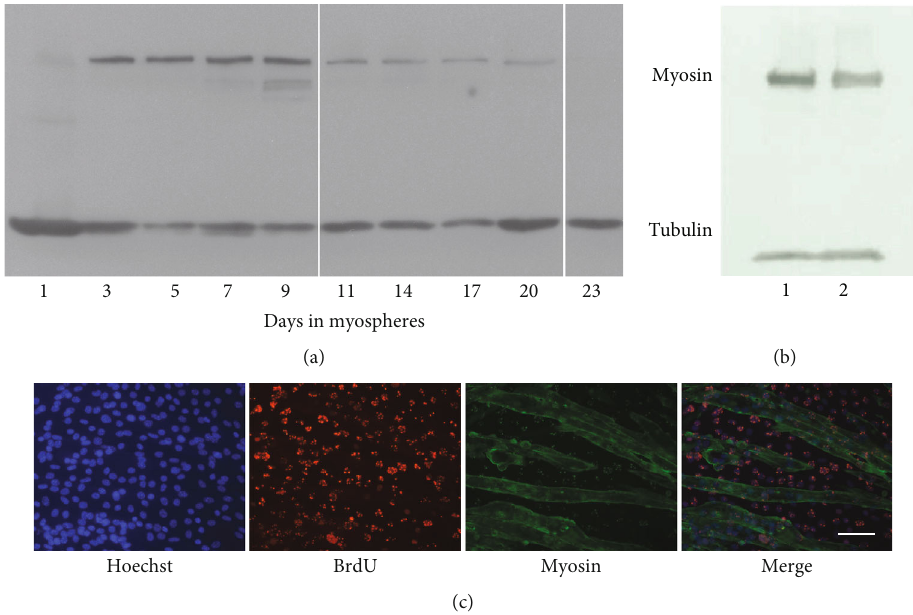
Figure 3: Trend of myogenic di ff erentiation during myosphere maturation and di ff erentiation potential retained in quiescent cells of mature myospheres. (a) Time course of myosin expression in myospheres by western blot from the 1st to 23rd day of culture. (b) The cells of mature myospheres retain the capacity to proliferate and di ff erentiate. The western blot quantitatively compares myosin expression in a monolayer: (1) original C2C12 cells that were never grown as myospheres and (2) cells derived from the dissociation of 23-day myospheres plated in a monolayer and allowed to di ff erentiate. (c) C2C12 cells dissociated from 23-day myospheres (mature); replated in a monolayer, the cells incorporate BrdU while proliferating before di ff erentiating and expressing myosin. Scale bar: 50 μ